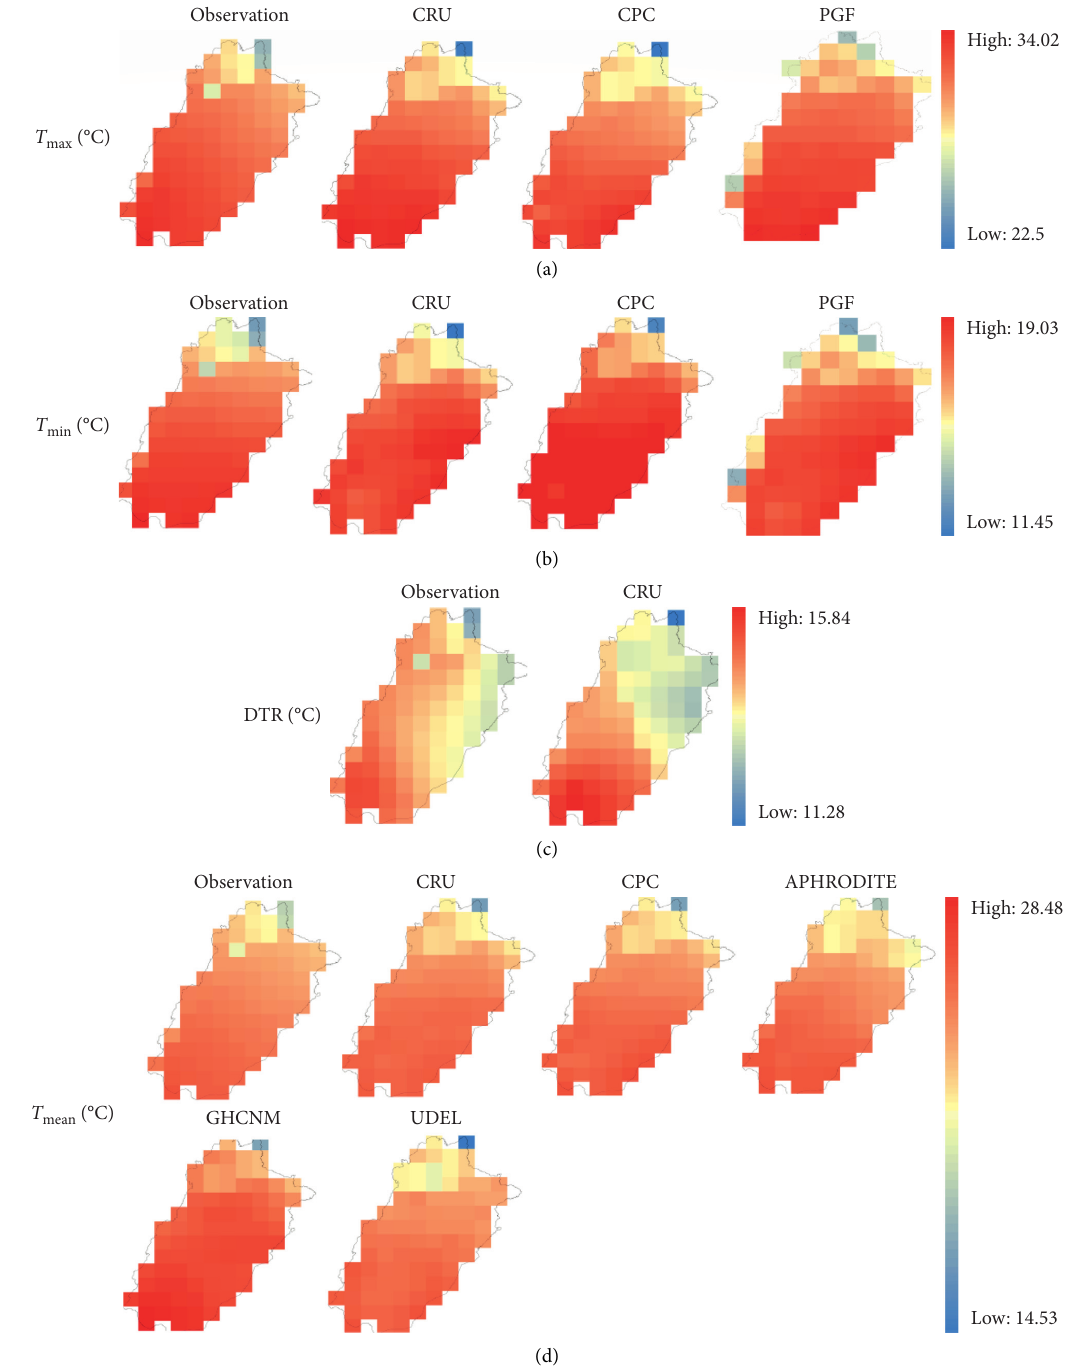
Figure 4: Spatial distributions of average annual temperature indices over Punjab. (a) T